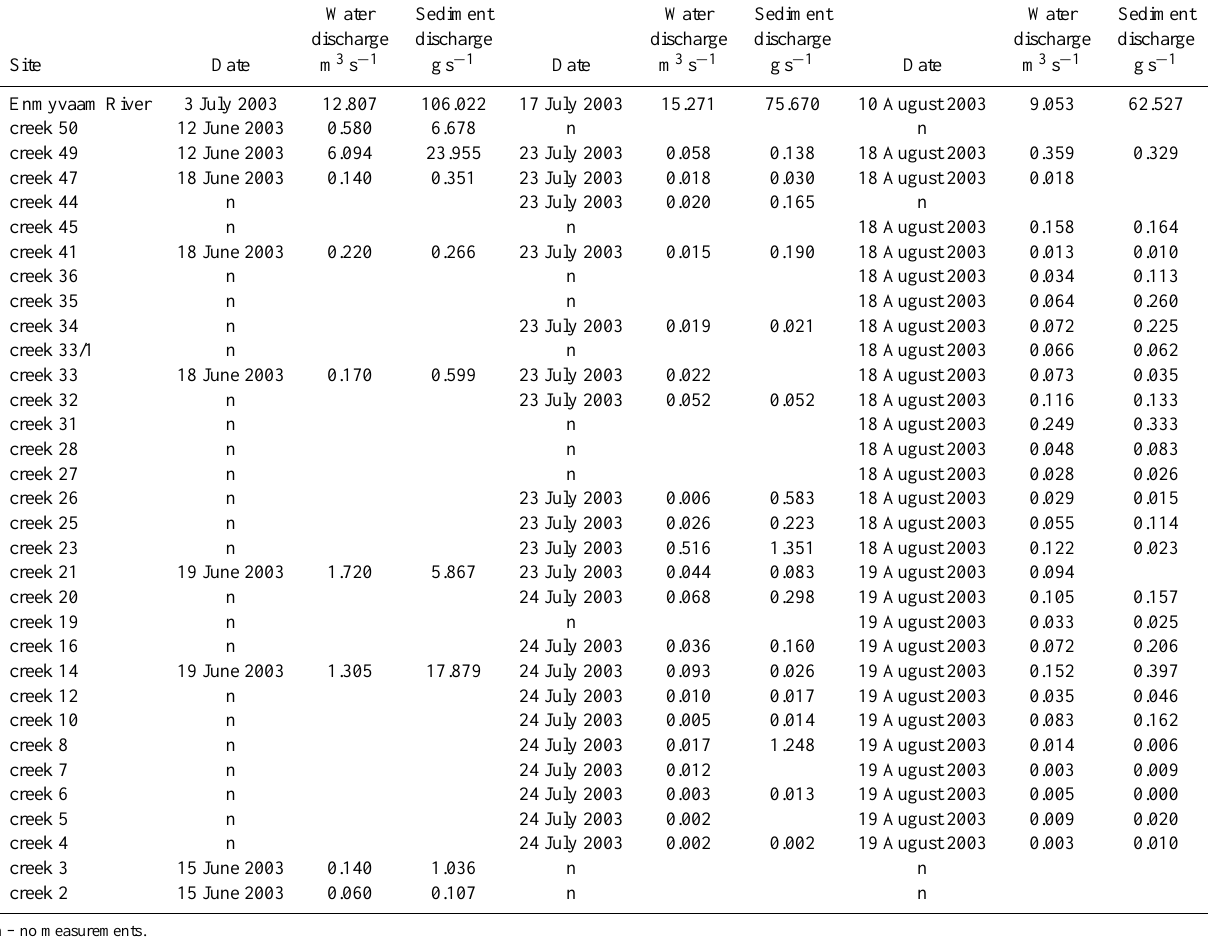
Table 1. Water and sediment discharge measured during spring and summer 2003 in the outlet river and inlet streams, Lake